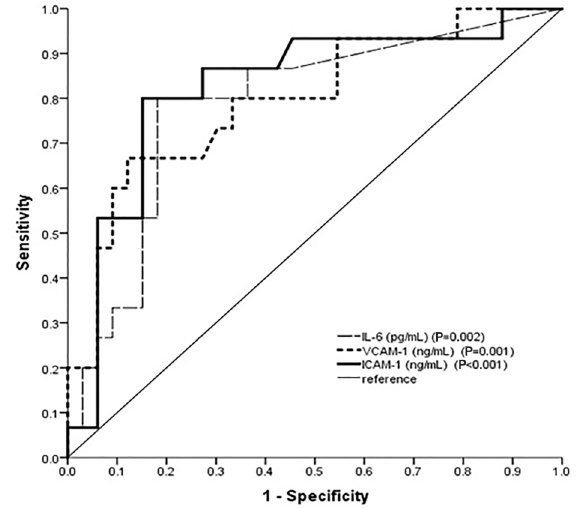
Figure 1. Receiver operating characteristics of interleukin-6 (IL-6), vascular cell adhesion molecule 1 (VCAM-1), and inter- cellular adhesion molecule 1 (ICAM-1) as biomarkers of post- acute myocardial infarction heart